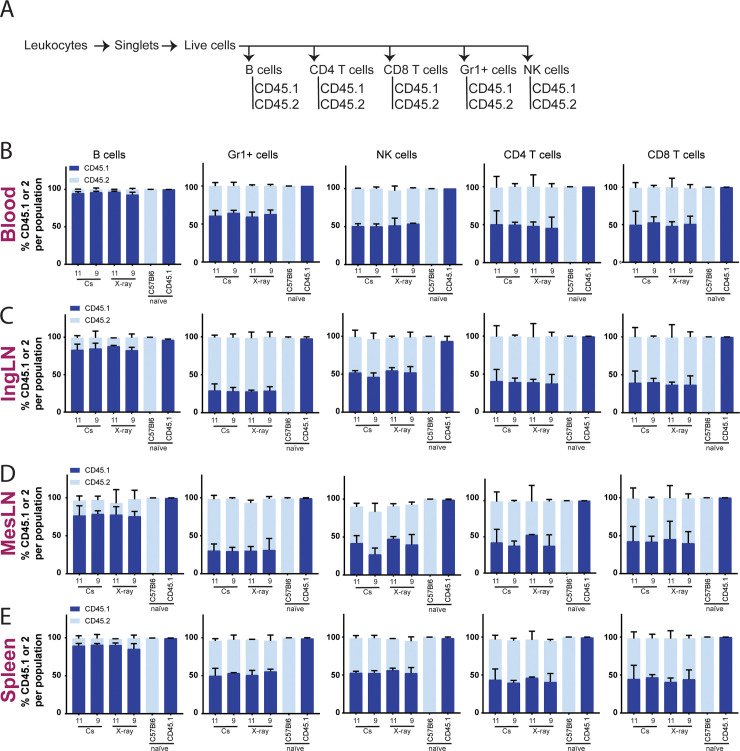
Chimerism of 564Igi mixed chimeras.A) Schematic overview of flow cytometry gating tree, gating layout can be seen in S2B Fig. Percentages of chimerism in blood (B), IngLN (C), MesLN (D) and spleen (E) after irradiation at doses of 9 and 11 Gy using either X-ray or Cs-137 irradiation. CD45.1 positive cells derive from the donor mice and CD45.2 cells are residual recipient cells or derive from the 564Igi donor compartment. Naïve mice have not been exposed to any treatment. In all bar graphs, the bar indicates the mean and error bars indicate the standard error of mean. Based on two-way ANOVA, irradiation modality only came out as an independent source of variation in the data for the NK cell population in MesLN (P = 0.0321), but in all cases there was a significant interaction effect (P<0.0001 throughout).